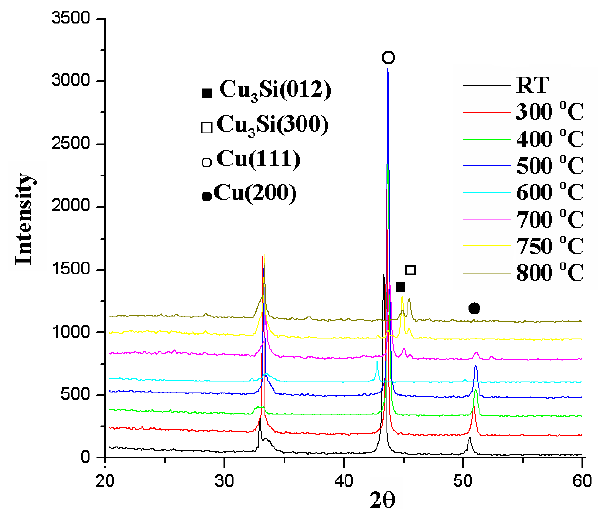
Figure 12. X-ray diffraction patterns for the structures of MgO (1 nm) sample annealed for 5 min at temperatures from room temperature to 800